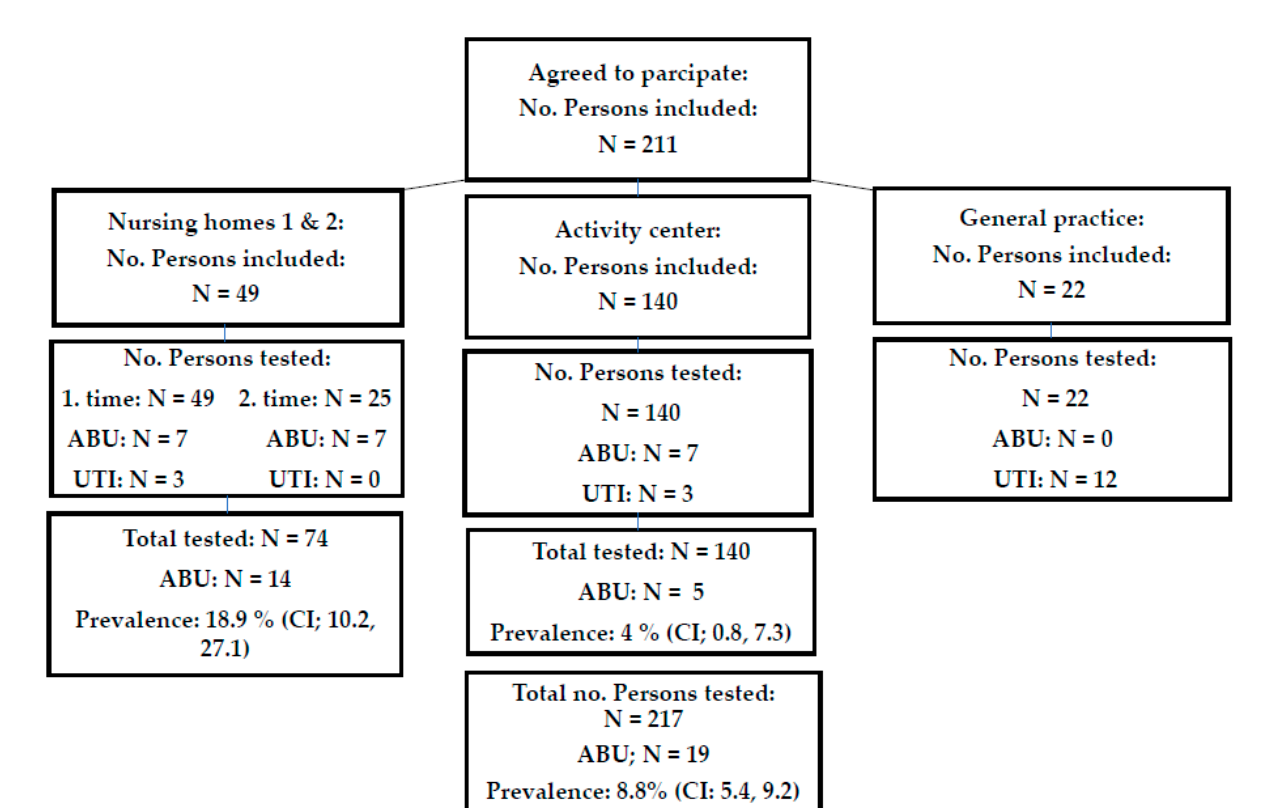
Figure 1. Diagram of sampling scheme and results of urine culture. ABU, asymptomatic bacteriuria; UTI, urinary tract infection. CI, 95% confidence interval.